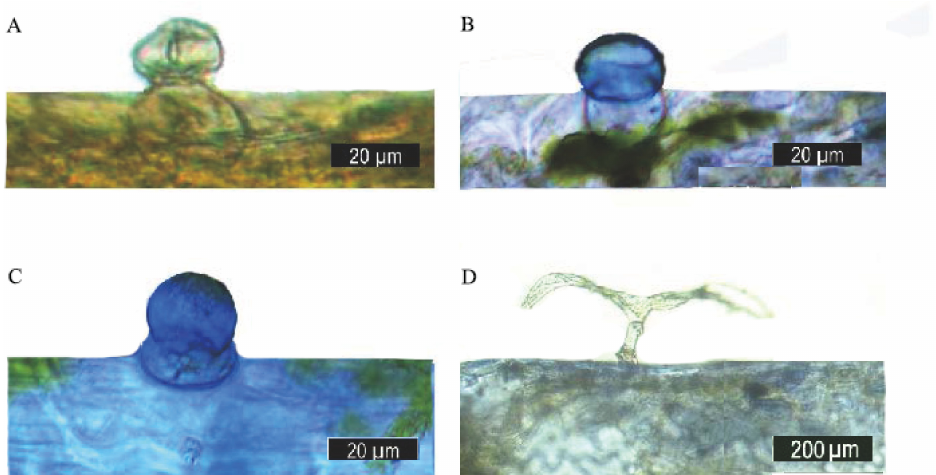
Figure 6. Histochemistry of the leaf glandular trichomes of O. taihangensis . ( A ) The capitate trichomes, before being stained. ( B , C ) positive Nadi reaction (blue-purple) in the head cell of a capitate trichome. ( D ) T-shaped non-glandular trichome without a reaction after